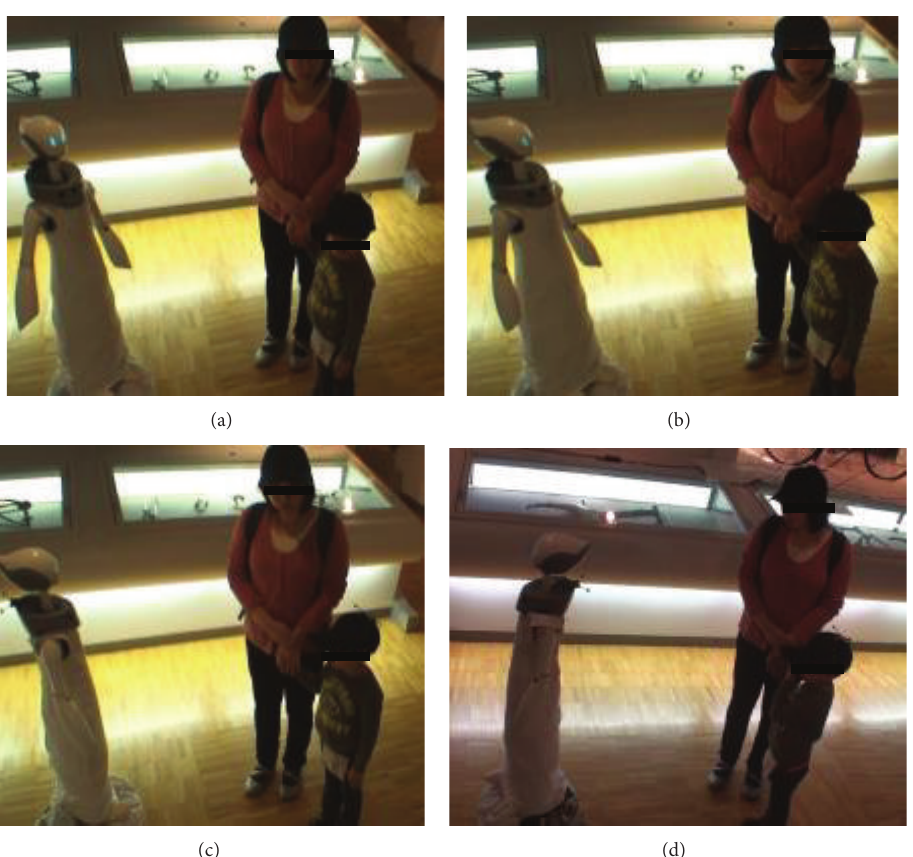
Figure 4: (a) Orientation when explaining an exhibit, (b) orientation when making eye contact and changing upper body orientation, (c) orientation when delivering summative assessment, and (d) orientation when moving on to the next exhibit.